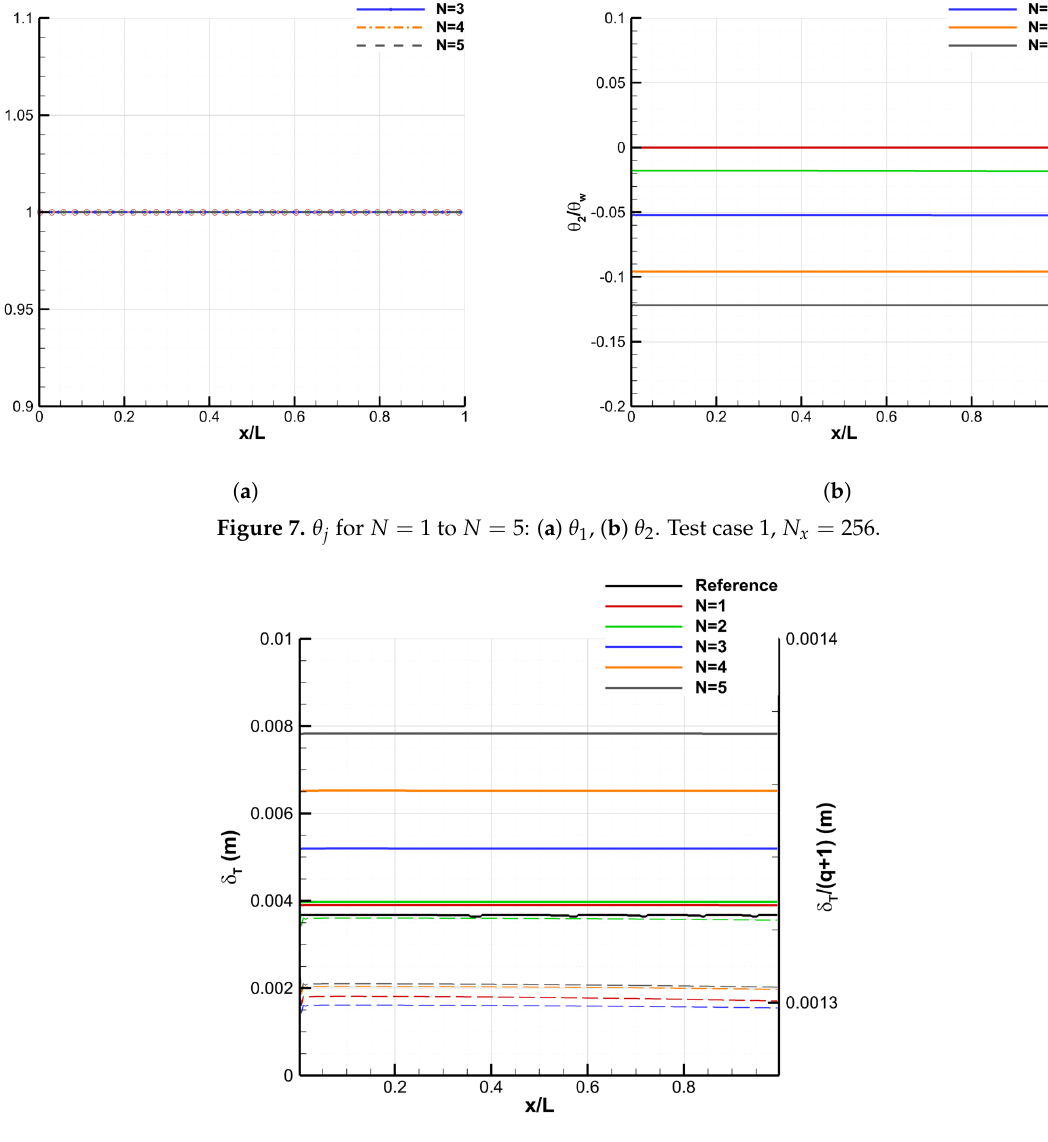
Figure 8. δ T for N = 1 to N = 5, and for the reference CLICET solution (solid lines). δ T / ( q + 1 ) for N = 1 to N = 5 (dashed lines). Test case 1, N x =